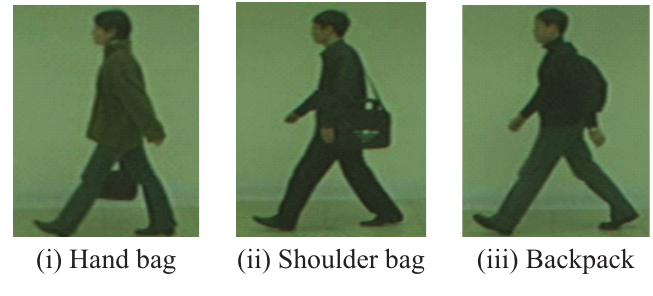
Figure 10. Example images of each category (CASIA-B-BG).